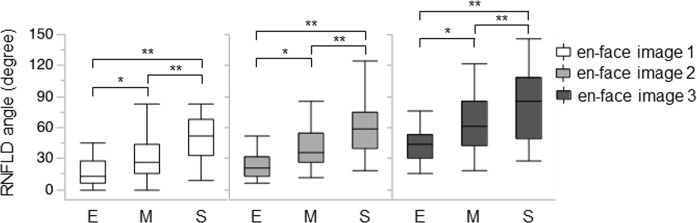
RNFLD angle at different stages of glaucoma.Boxplot showing the RNFLD angle in the en-face images at different depths in different glaucoma stages. E, M, S mean Early, Moderate, Severe stage. *: p<0.05, **: P<0.01.